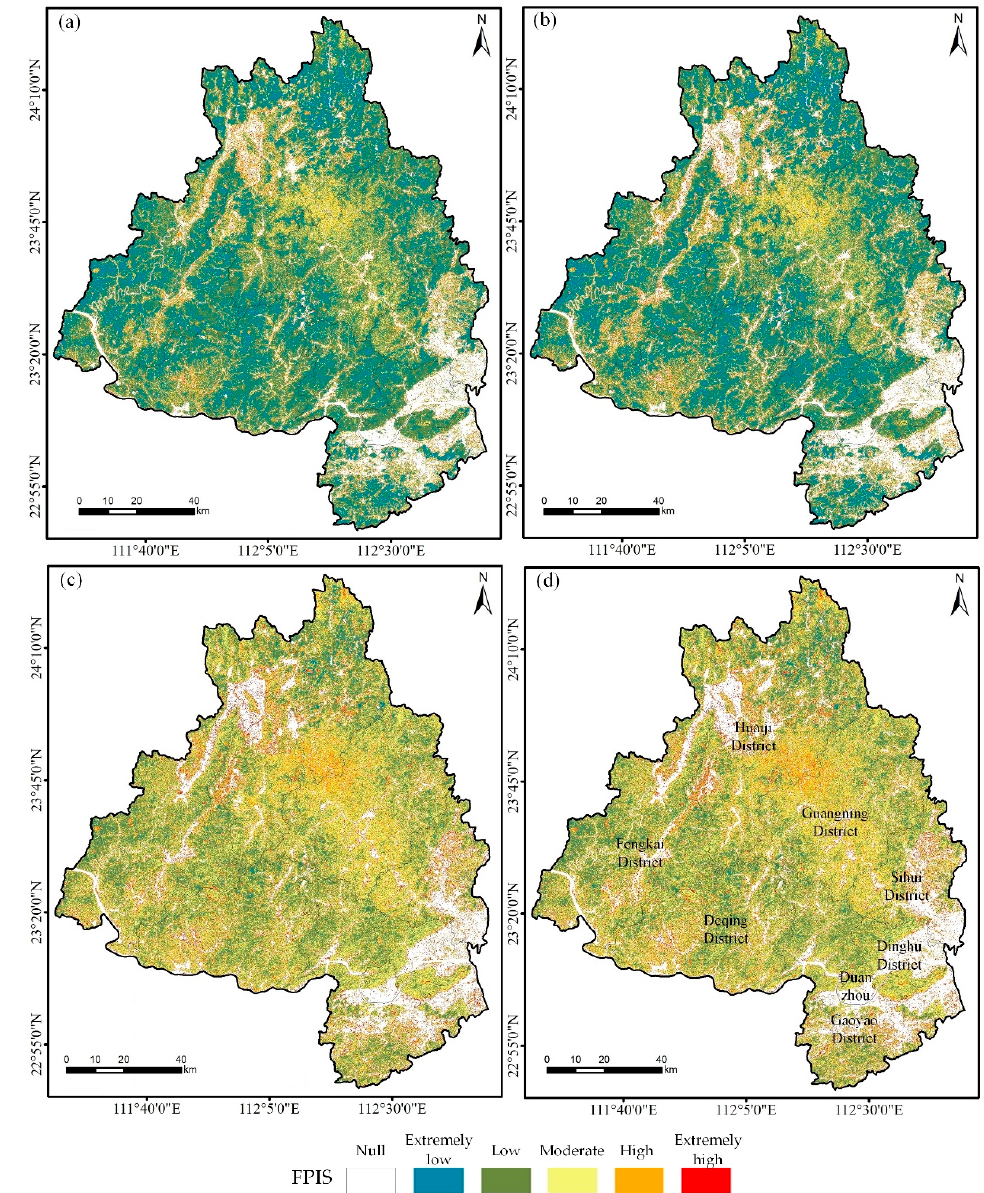
Figure 4. Forest fire risk in Zhaoqing, based on the optimized FPIS model. 20 October ( a ), 5 November ( b ), 21 November ( c ) and 7 December ( d ), 2019.